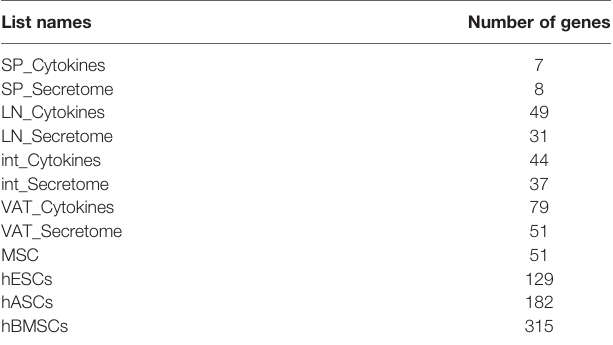
TABLE 11 | The cytokine genes and secretomic genes identi fi ed in tissue Treg and stem cells were summarized